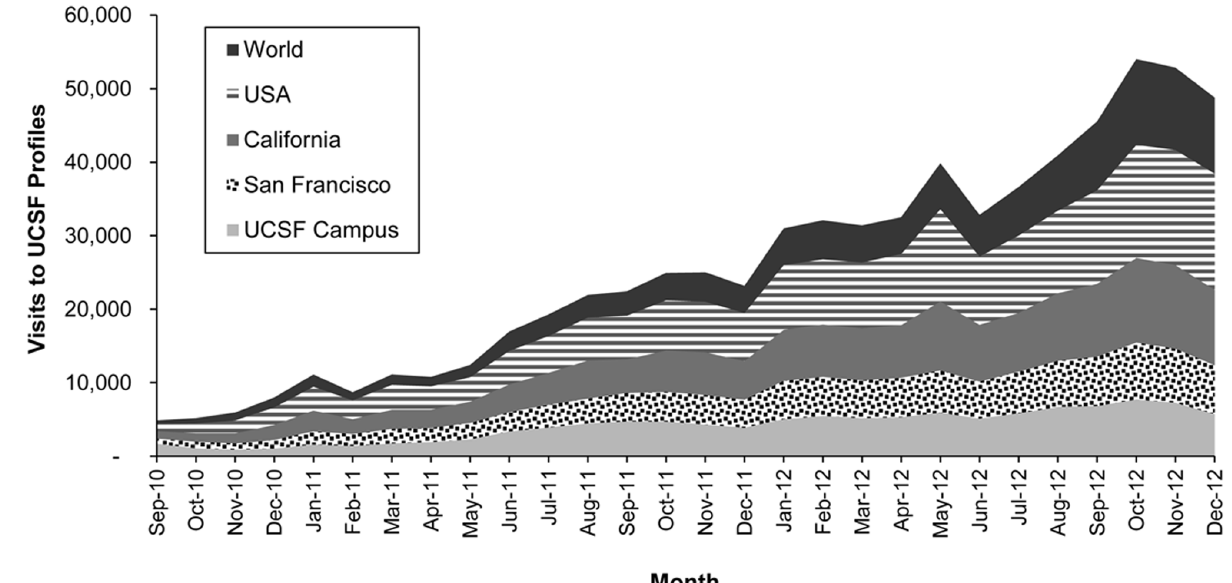
Figure 2. Location of visitors to Profiles for the 28 months since